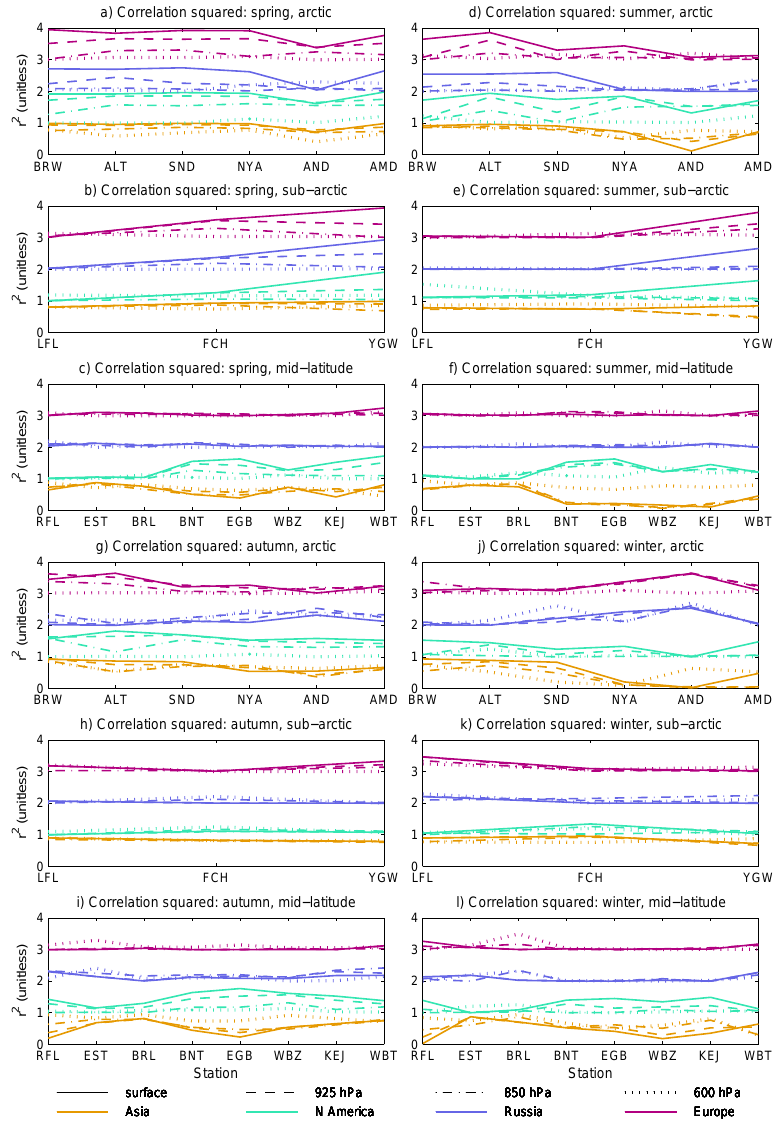
Fig. 5. Shown for each source region at the indicated station, level and season is the correlation squared between the base run’s mercury concentrations and the concentrations simulated using the specified source region’s emissions alone. Values from North America, Russia and Europe are increased successively by unity to promote readability. Table 1 identifies whether GEM or TGM correlations are calculated at the surface. GEM correlations are calculated at all stations at 925, 850 and 600hPa. Stations from each station group are arranged from west to